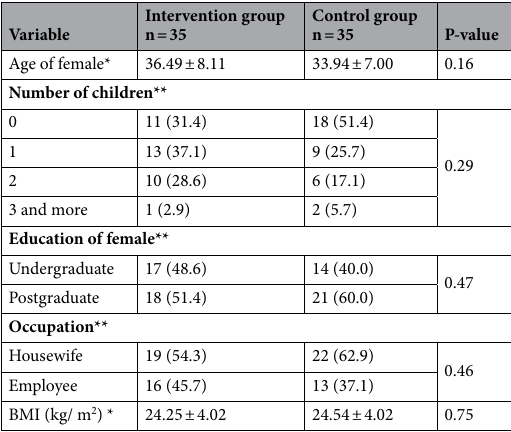
Table 1. Comparison of demographic characteristics between intervention and control groups. BMI Body Mass Index. *Values are given as mean ± SD using t-test. **Values are given as a number (%) using Chi-squared test.